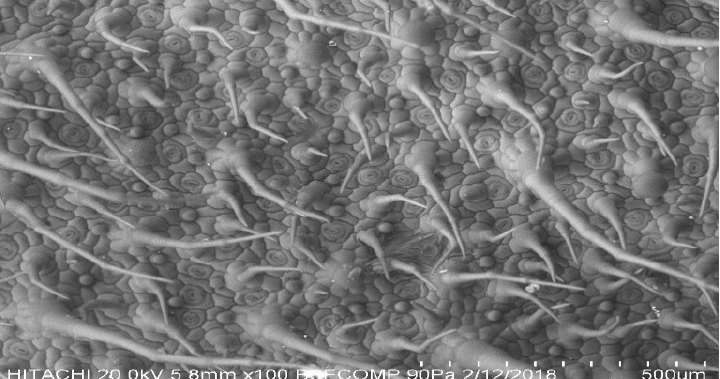
Figure 6. SEM image of raw P . amboinicus leaves.